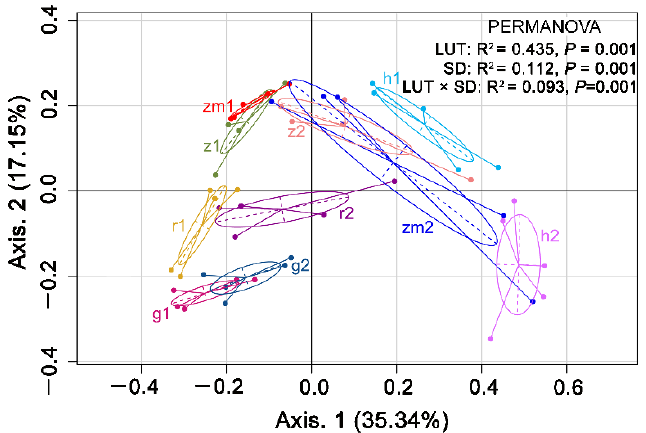
Figure 4. Principal coordinate analysis (PCoA) of soil bacterial communities (Bray–Curtis) for all soil samples. g1: grass land at 0–20 cm; g2: grass land at 20–40 cm; f1: secondary forest land at 0–20 cm; f2: secondary forest land at 20–40 cm; z1: Zanthoxylum planispinum land at 0–20 cm; z2: Zanthoxylum planispinum land at 20–40 cm; h1: Hylocereus spp. land at 0–20 cm; h2: Hylocereus spp. land at 20–40 cm; zm1: Zea mays land at 0–20 cm; zm2: Zea mays land at 0–20 cm.